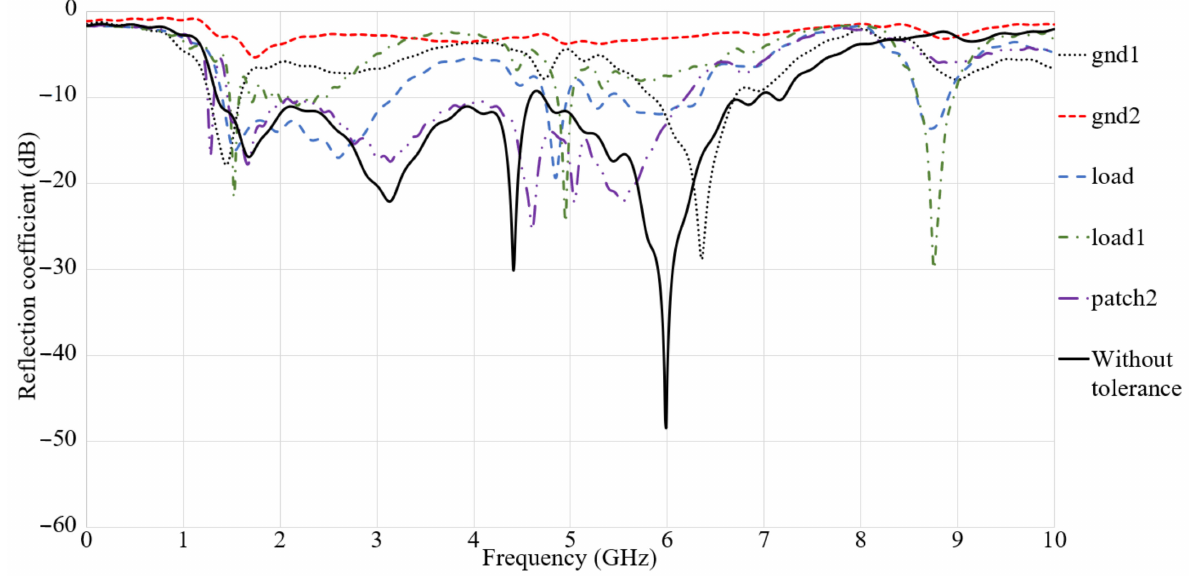
Figure 7. S 11 result of the antenna in terms of fabrication